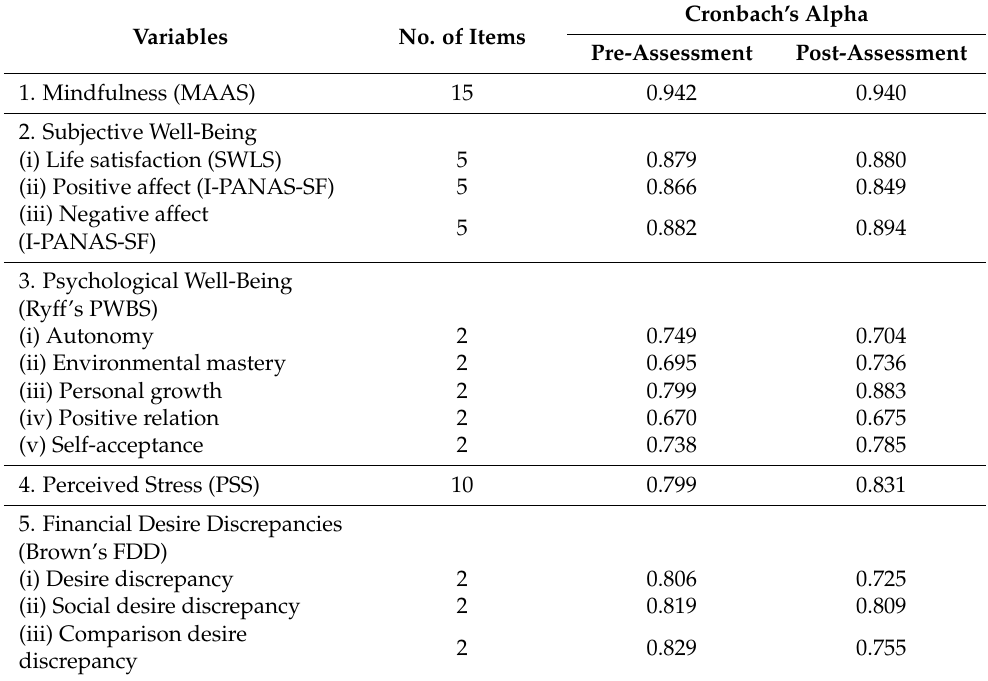
Table 3. Reliability